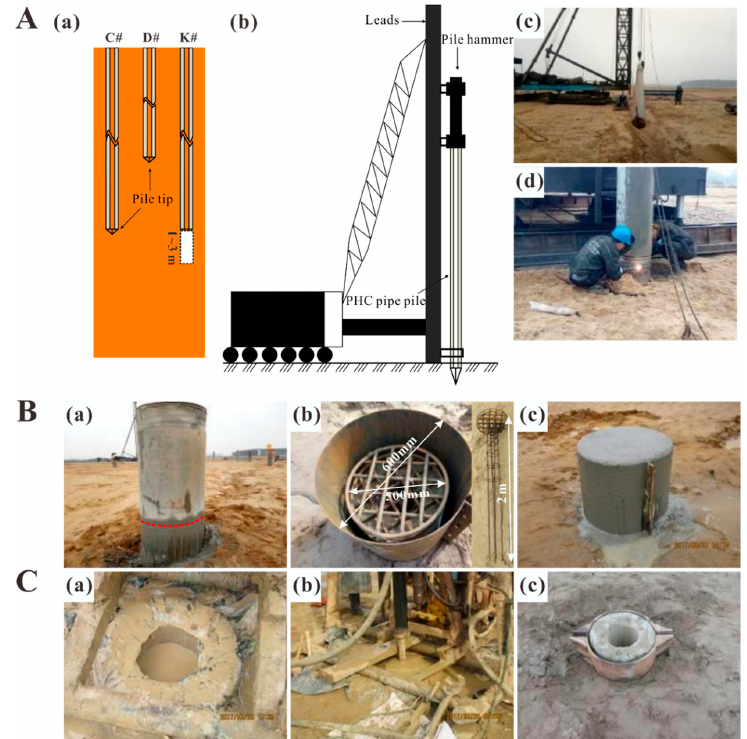
Figure 4. ( A ): PHC pipe pile types (C-type, D-type, and K-type) and schematic figure of pile driving method by hammer; ( B ): Pile cap making for C-type and D-type PHC pipe piles: ( C ): Pile cap making for K-type PHC pipe piles.